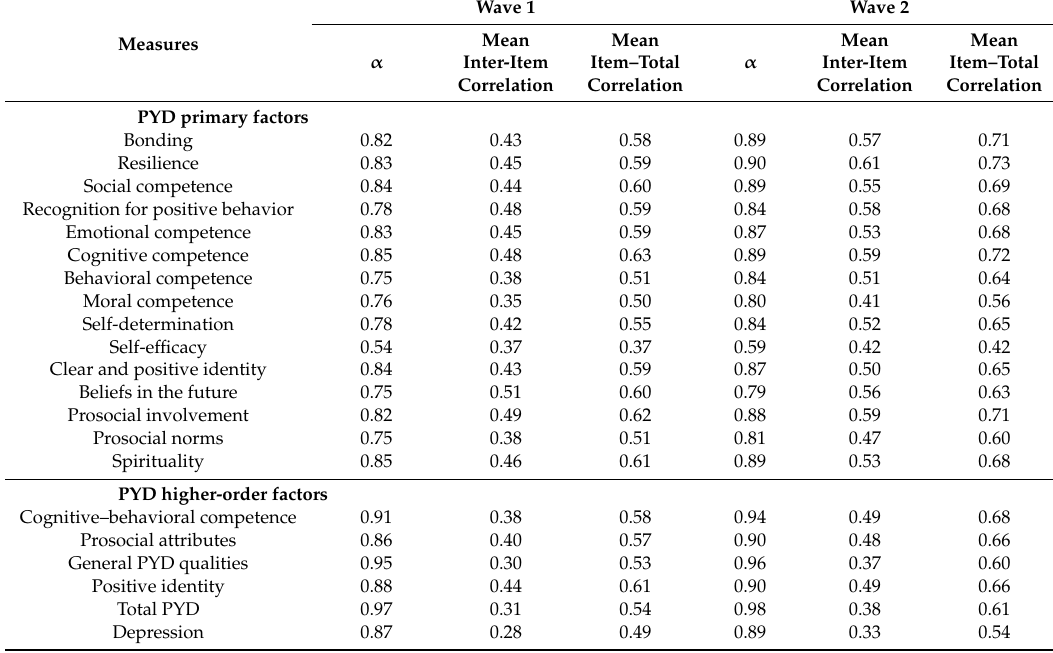
Table 1. Reliability of